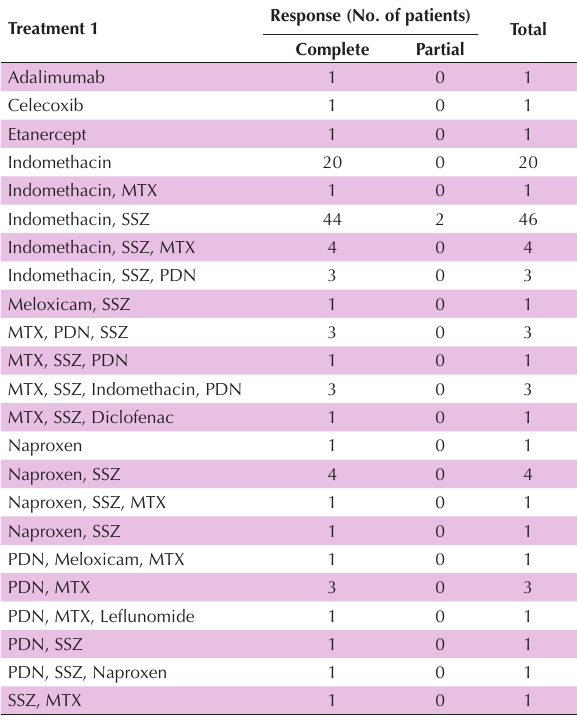
Table 10. Treatment response status (complete or partial) of drugs used in the second treatment of the disease Treatment 2